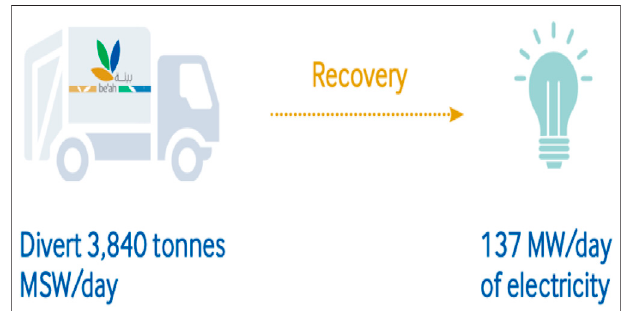
FIGURE 9 | WTE plant in Barka, Oman.